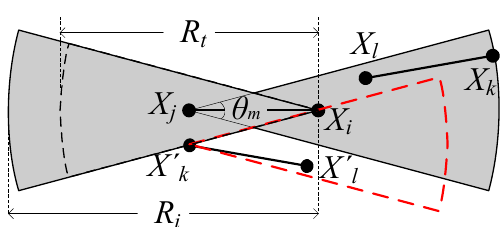
Figure 3. The Interference